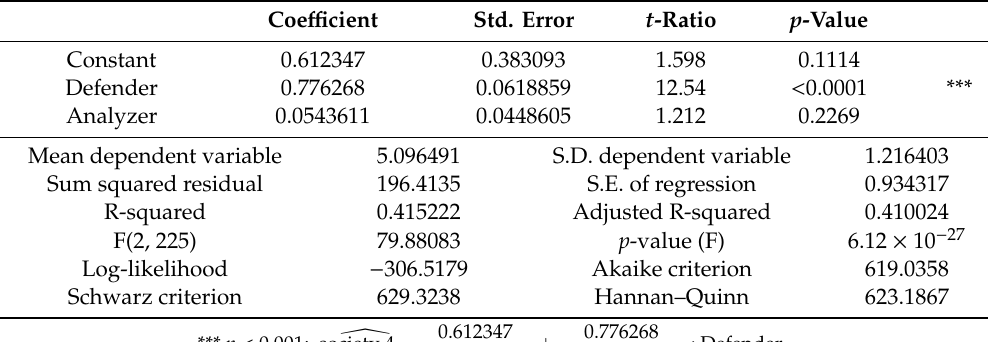
Table 8. Model 8: OLS, using observations 1–228. Dependent variable: Society